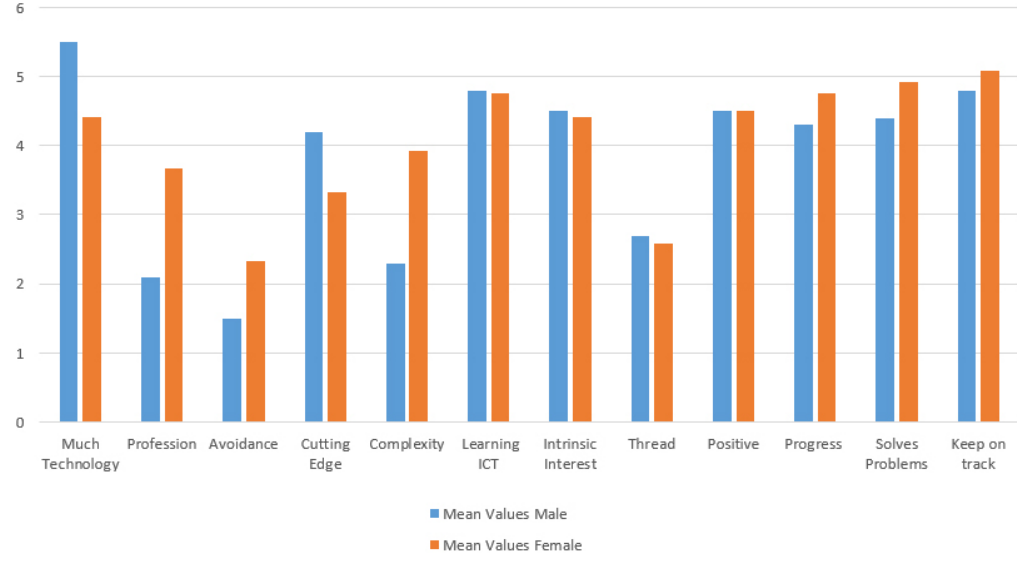
Figure 12. Mean values of the technology-oriented questions, ranging from 6 (strongly agree) to 1 (strongly